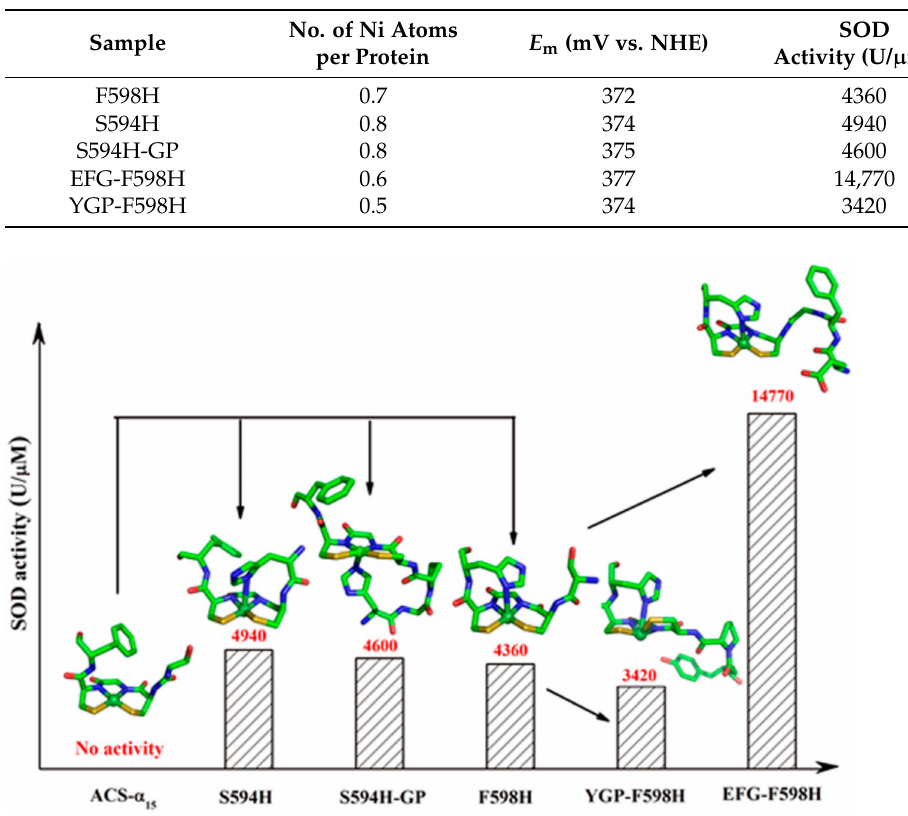
Table 2. E m and SOD activity (pH 7.5) of ACS- α 15 Mutants.